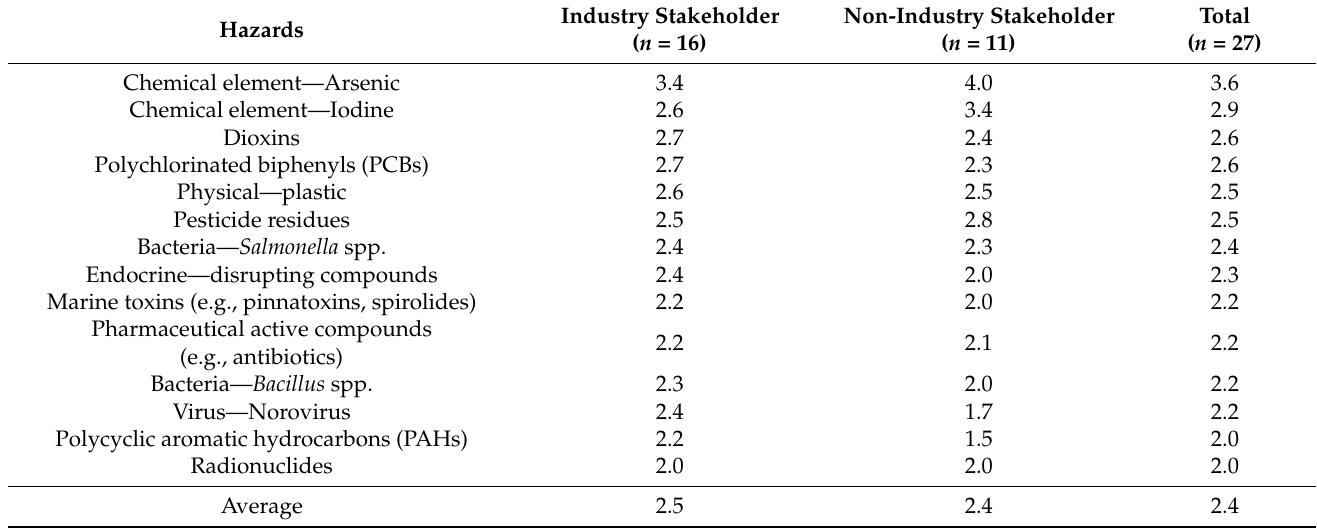
Table 1. Survey scores regarding the risks for 14 food safety hazards in seaweed with 5: biggest risk and 1: smallest risk for hazards according to industry, non-industry, and all